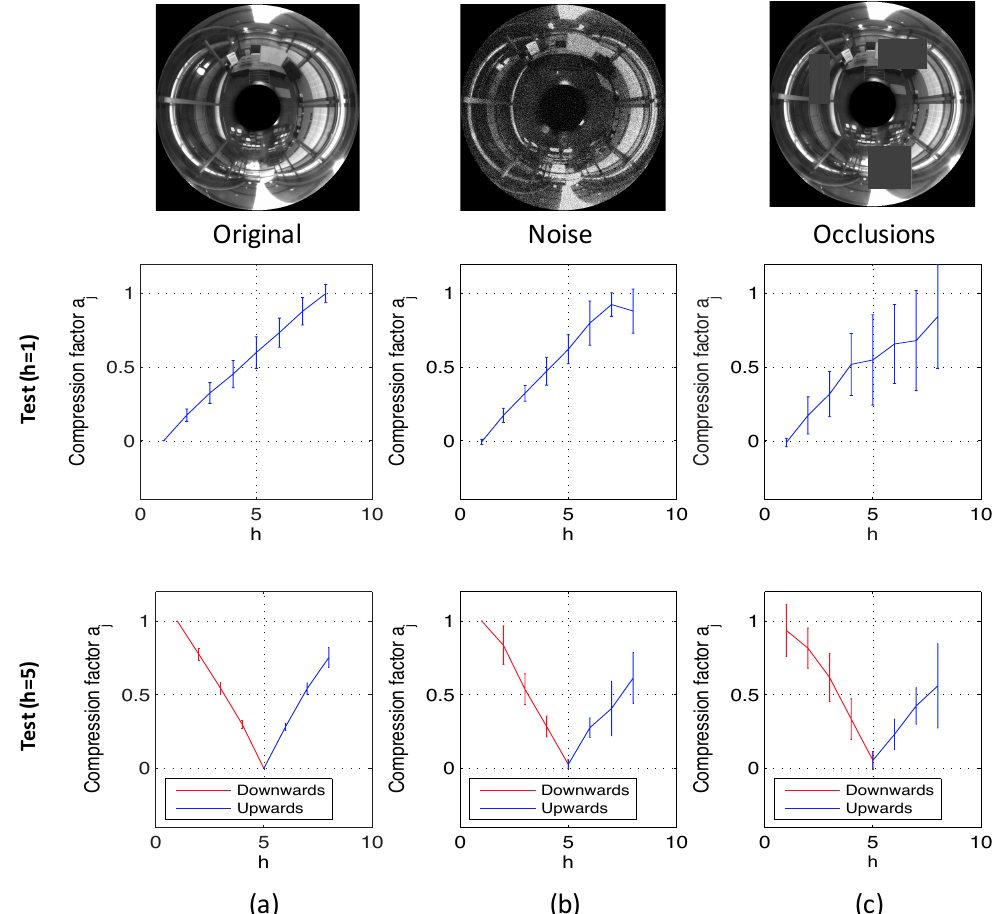
Figure 17. Altitude estimation using the method based on SURF features and the indoors database, using reference images at the bottom (h = 1) and in the middle of the height (h = 5). Average and standard deviation of all locations considering ( a ) the original test images, ( b ) noise added to the test images and ( c ) occlusions added to the test